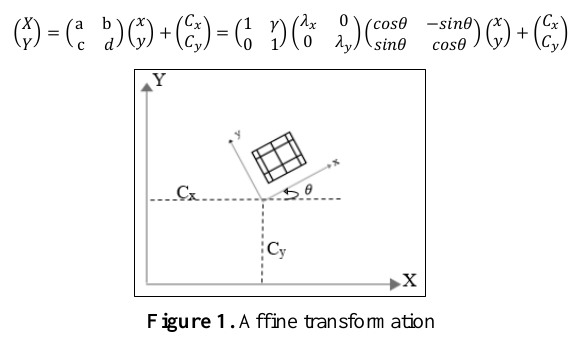
Figure 1. Affine transformation